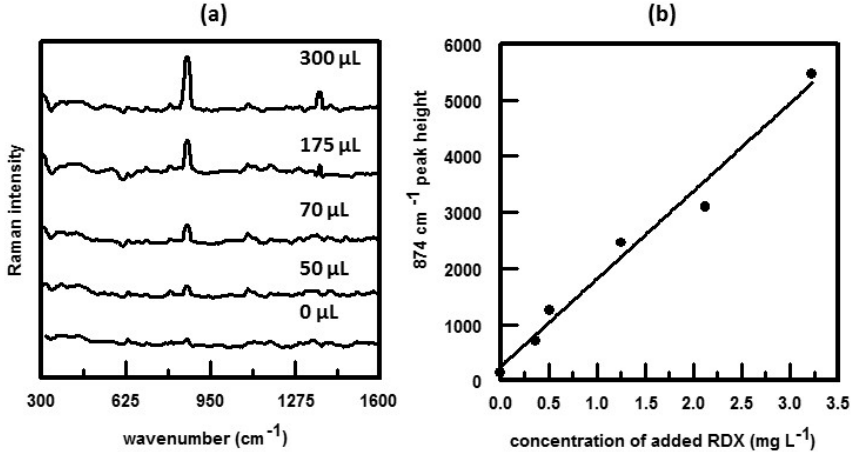
Figure 5. ( a ) SERS spectra of contaminated groundwater sample obtained using the standard addition method. Volume of RDX stock solution (177.7 mg L − 1 ) added to each sample is indicated. Spectra were obtained using 785 nm excitation; ( b ) Standard addition curve for determining the RDX concentration in the groundwater sample. Reproduced with permission from John Wiley and Sons, 2010 [39].